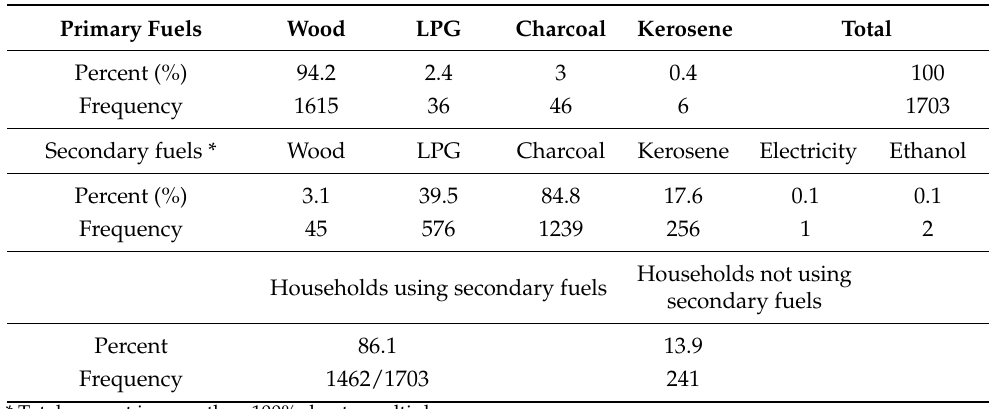
Table 1. Adjusted distribution of primary and secondary fuels.